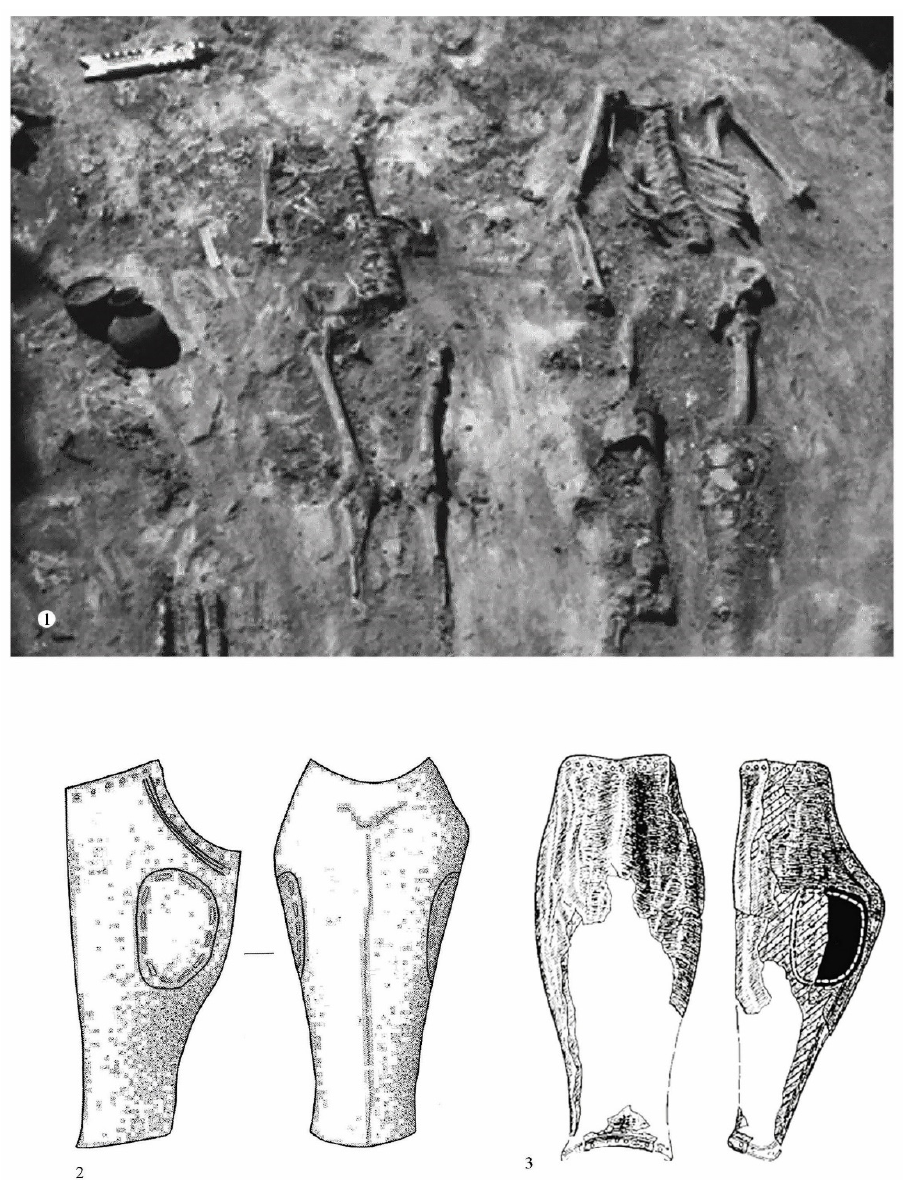
Figure 2. Vodoslavka Barrow 6 Burials 1–2. (1)—Skeletons of the buried. Left—female, right—male (photograph from field report); (2)—Greave from the Barrow 6. Reconstruction by Е .B. ˇCernenko (after: ˇCernenko 2006, pl. 33: no. 665); (3)–greave from the Barrow 6. Reconstruction by S.A. Kupriy (after: Kupriy et al. 2019, fig. 5: